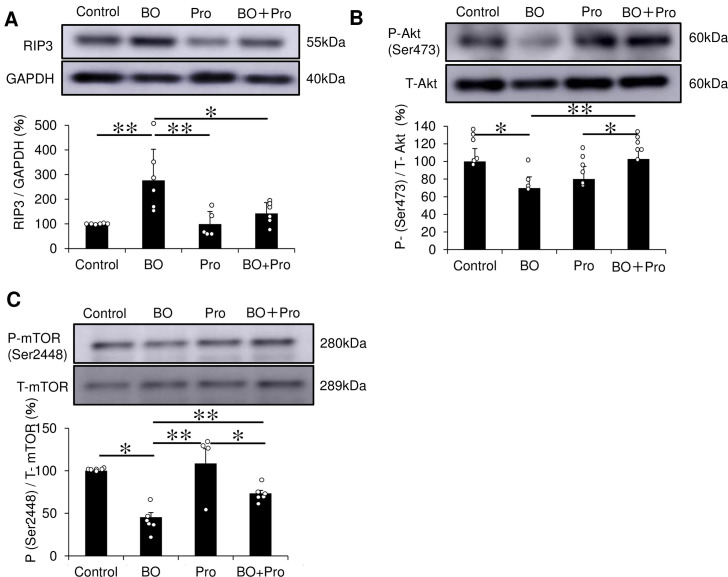
Effects of BO on RIP3 and Akt/mTOR signaling in the heart.(A) Expression of RIP3, a key mediator of necroptosis, was significantly increased in the BO group, but this increase was blocked in the BO + Pro group. *P < 0.05 or **P < 0.01 by one-way ANOVA followed by the Tukey-Kramer post hoc test (S7A Fig of S1 Data). (B) Akt phosphorylation at Ser 473 was significantly decreased in the BO group, but this decrease was blocked in the BO + Pro group. *P < 0.05 or **P < 0.01 by one-way ANOVA followed by the Tukey-Kramer post hoc test (S7B Fig of S1 Data). (C) mTOR phosphorylation at Ser 2448, a specific marker of mTORC1 formation, was significantly decreased in the BO group, but this decrease was blocked in the BO + Pro group. *P < 0.05 or **P < 0.01 by one-way ANOVA followed by the Tukey-Kramer post hoc test (S7C Fig of S1 Data). Data show means ± SD and scattered dots show individual data. Full-size images of immunoblots are presented in S1 Data of supporting information.